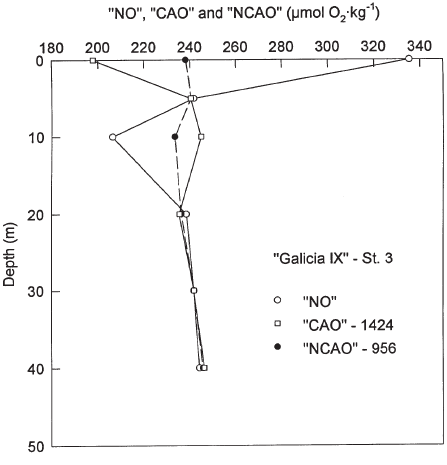
F IG . 3.- Vertical distribution of the chemical parameters “NO”, “CAO” and “NCAO” during a Gymnodinium catenatum red tide at station 133 of “Galicia IX” cruise on 3 October 1986. The CO